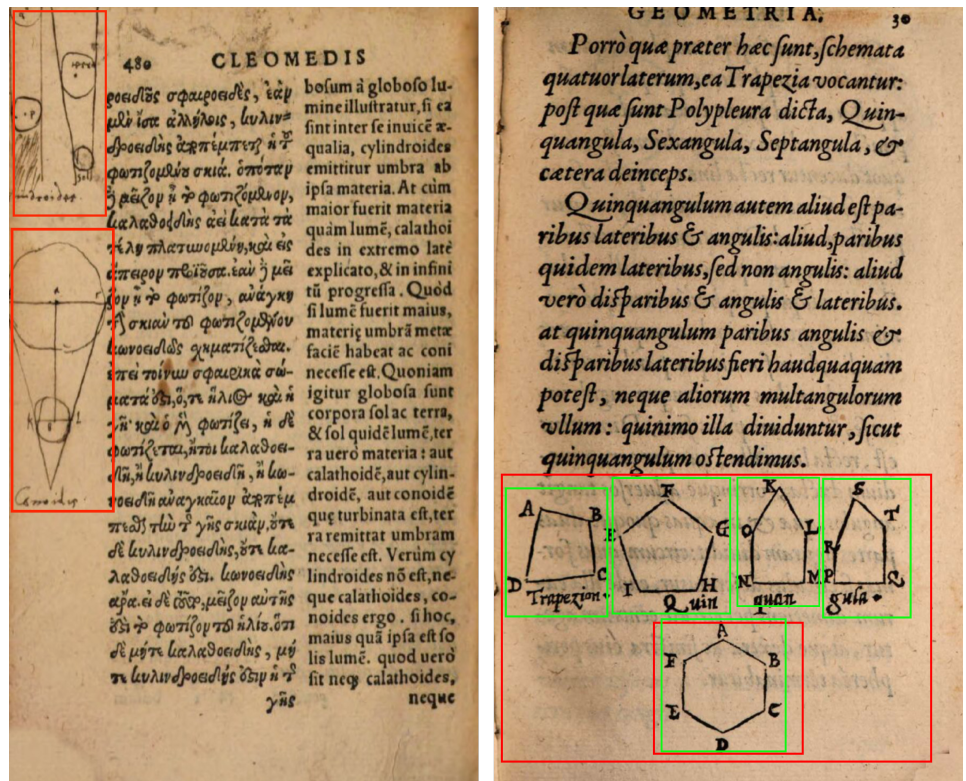
Figure 7. Different types of errors arising from our S-VED annotation strategy. ( Left ) False Posi- tive Content Illustration detection of hand-drawn images in the margins ( Procli de Sphaera Liber I. , 1561, Basel, München, Bayerische Staatsbibliothek